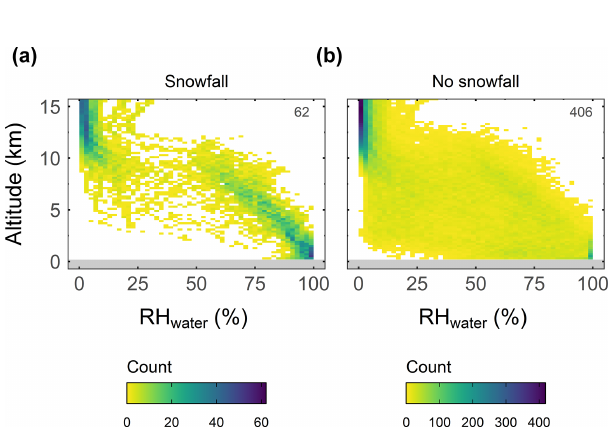
Figure A5. Same plot as Fig. 5, but for RH water